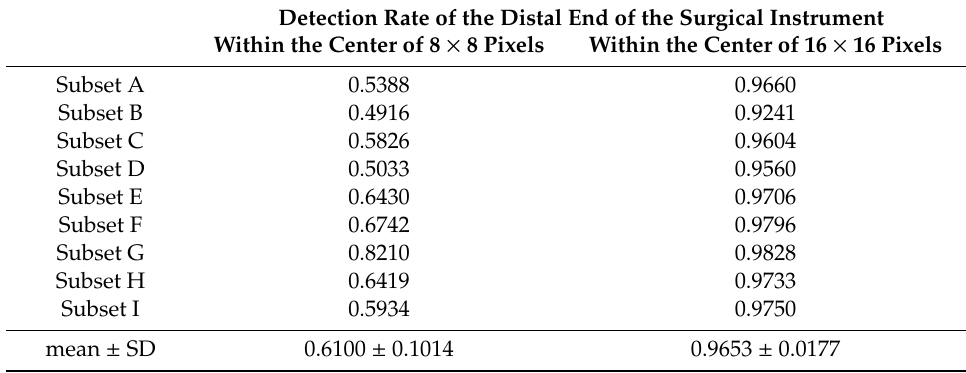
Figure 7. Representative examples of the bounding box and surgical instrument distal end detection results. Table 2. The detection rate of the distal end of the surgical